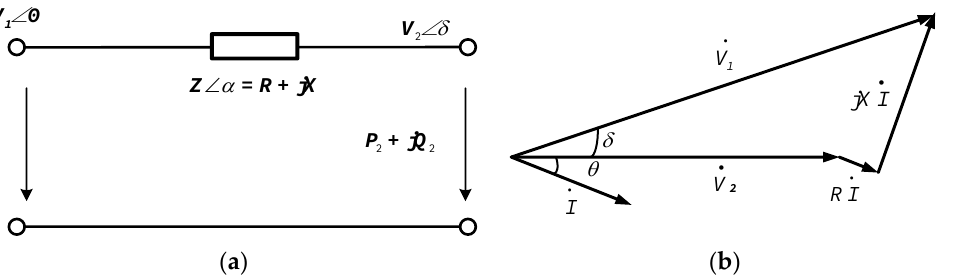
Figure 3. Equivalent circuit and phasor diagram of simple linear network in power system. ( a ) The Equivalent Circuit of simple linear network ( b ) The Phasor Diagram of simple linear network in power system.